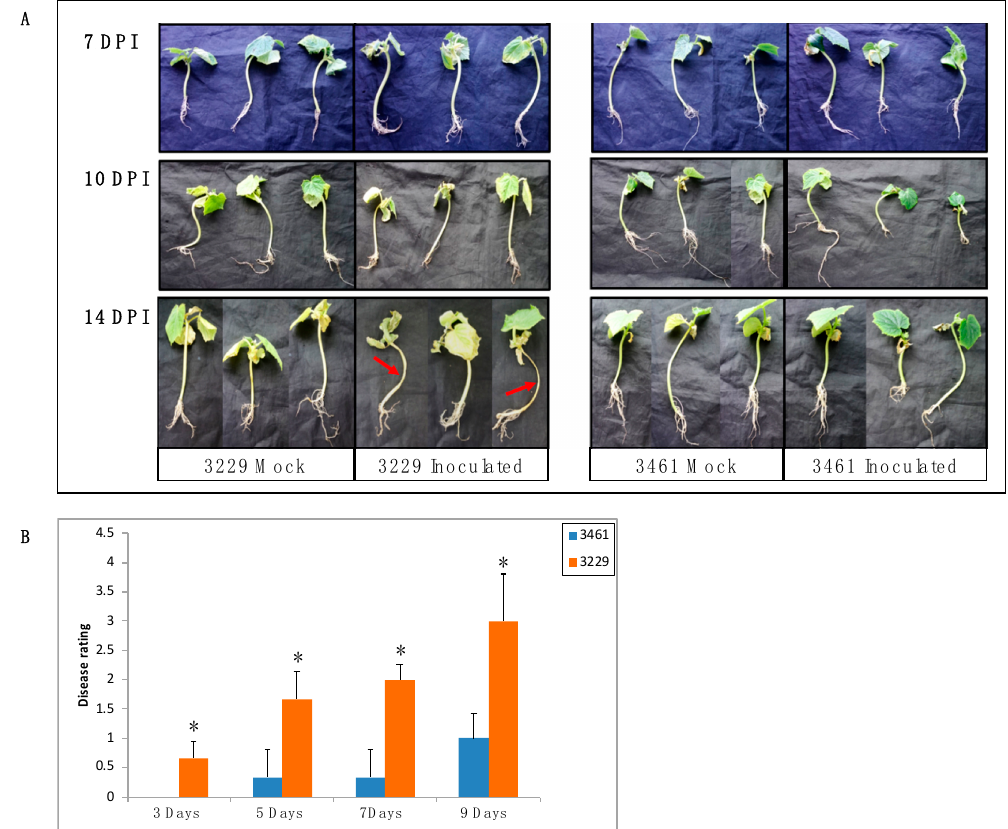
Figure 5. Fusarium wilt infection assay. ( A ) Disease symptoms of fusarium wilt in cucumber inbred lines 3229 and line 3461. The roots were inoculated with F. oxysporum f. sp. Cucumerinum Owen race 3. Mock plants were treated with distilled water. Red arrows show severe wilting in the stem. ( B ) Average disease symptom rating of both lines was scored using a disease rating scale (0–4). Values are shown as means ± SD ( n = 6). (*, p < 0.05; Student’s t -test).